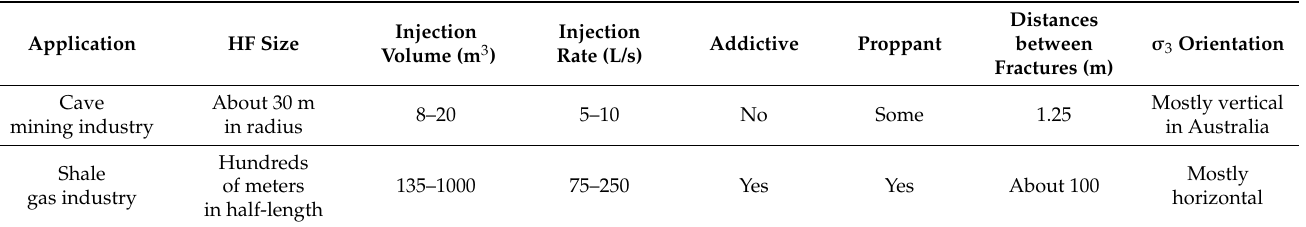
Table 1. Differences between hydraulic fracturing in the cave mining industry and hydraulic fractur- ing in the shale gas industry, revised by Bunger et al. [43] and Adams and Rowe